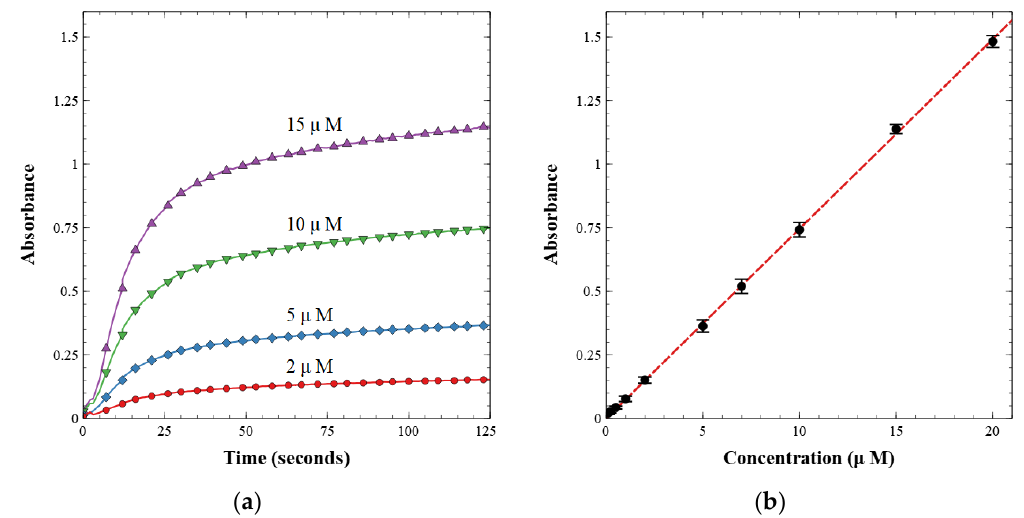
Figure 7. ( a ) Absorbance over time of pre-made standard nitrite concentrations; ( b ) calibration curve of nitrite lab-on-chip sensor showing absorbance versus concentration. Sensors 2019 , 19 , x FOR PEER REVIEW